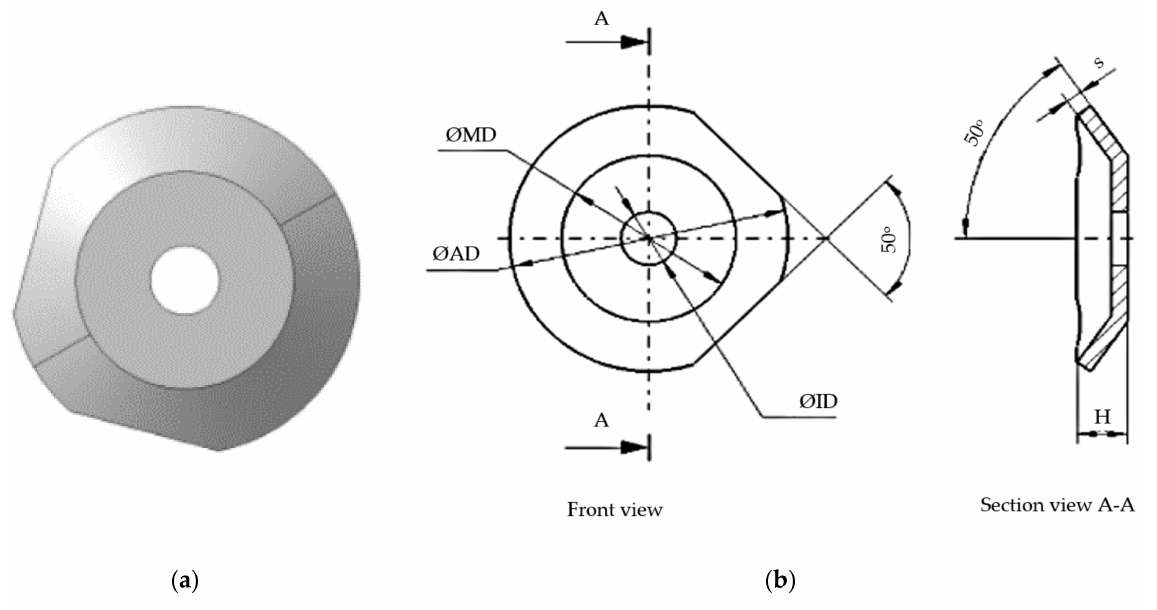
Figure 2. Constructively modified spring washer: ( a ) image; ( b ) dimensional elements (ØID = 5 mm; ØAD = 10 mm; ØMD = 7.5 mm H = 0.9 mm; s = 0.40